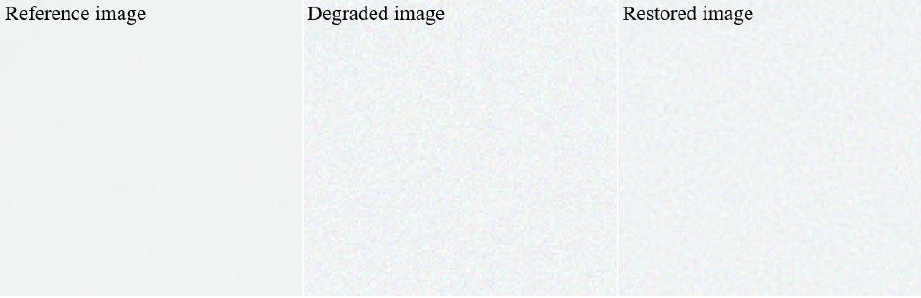
Figure 4. Noise patches of the three images in Figure 3 for the background areas marked with box A .